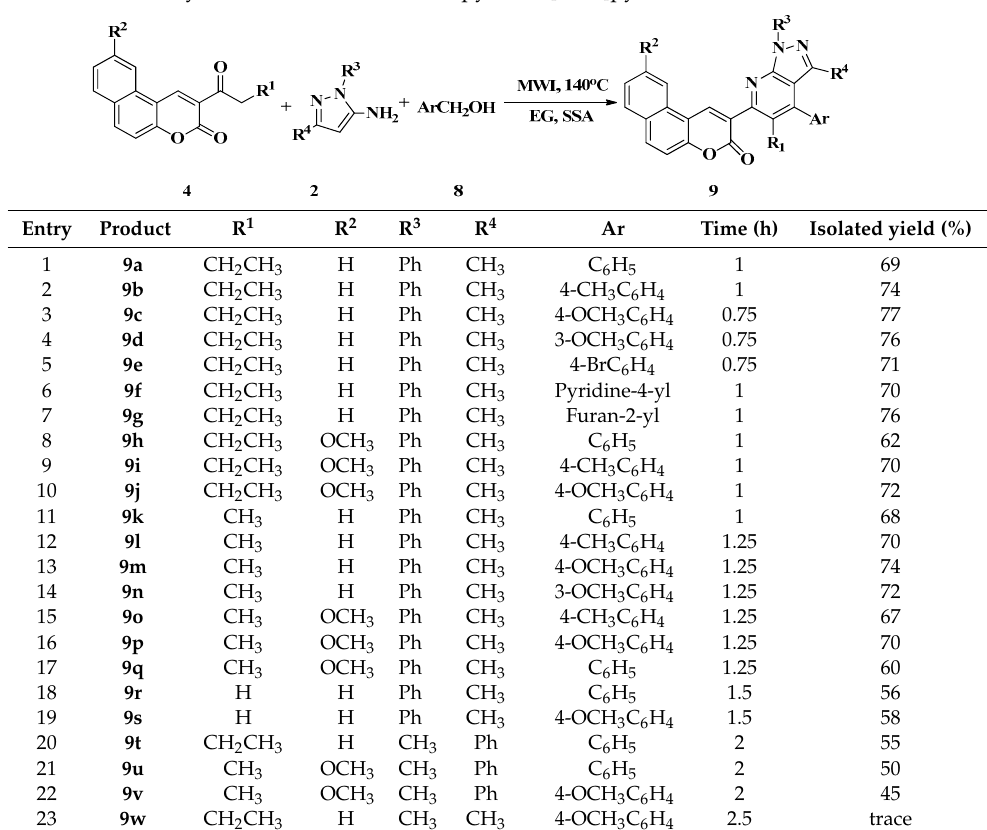
Table 2. Synthesis of coumarin-fused pyrazolo[3,4- b ]pyridine derivatives 9 a .